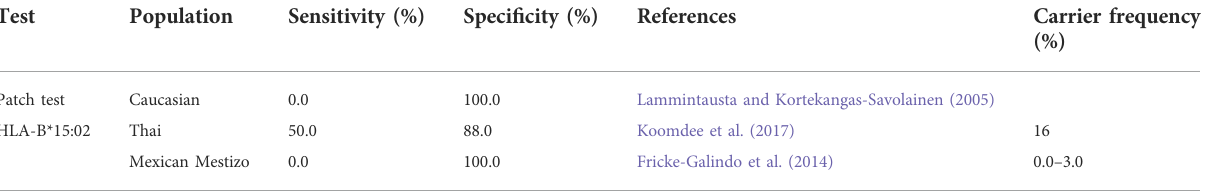
TABLE 9 Sensitivity and speci fi city of patch tests and HLA tests for lamotrigine-induced